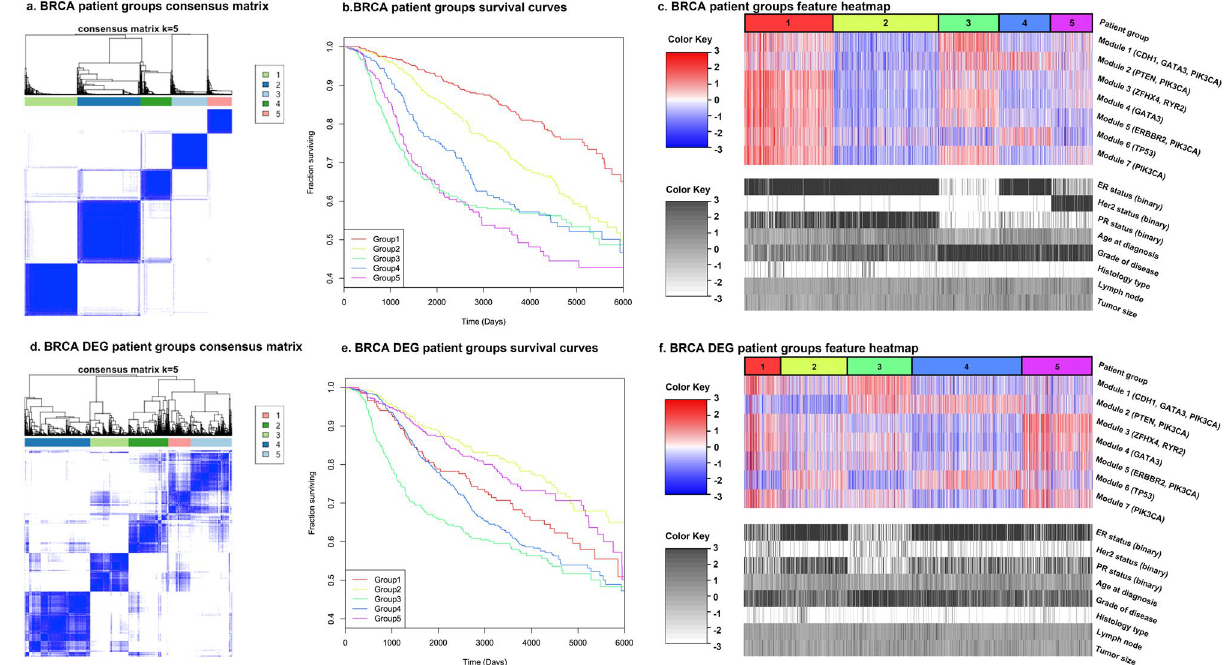
Figure 3. The consensus matrices of PAM consensus clustering for identifying patient groups for BRCA, the survival curves of the resulting patient groups, and the feature heatmaps. Patient groups were identified using all DEG modules and clinical features. DEG patient groups were identified using only DEG modules. For the heatmaps, the features were normalized across all patients. Values above 3 and below − 3 are compressed into 3 and − 3, respectively. The dominant SGAs of each DEG module are listed by the module index. The values of the clinical features of each DEG patient group are also given as a